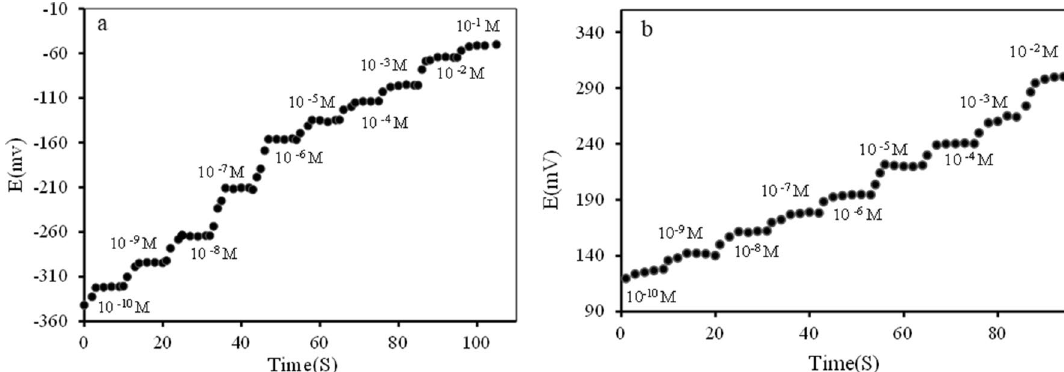
Figure 3. Response time of ( a ) copper (II) selective CPE and ( b ) chromium (III) selective CPE in various concentrations of (Fig. 2b) for modified copper (II) and chromium (III) selective electrodes, respectively. These results suggest the good performance of the sensors in this pH range. The fluctuations below pH of 4.5 and 5 could be associated with the partial protonation of the utilized ionophore. Protons can compete with copper (II) and chromium (III) at higher H + concentrations. Based on the observations, at pH values below 4.5 and 5, the concentration of H + is higher enough to win in the competition with copper (II) and chromium (III), respectively. At higher pH values, the changes could be caused by the formation of various copper (II) and chromium (III) hydroxides 26,28 . The response time of modified CPE.